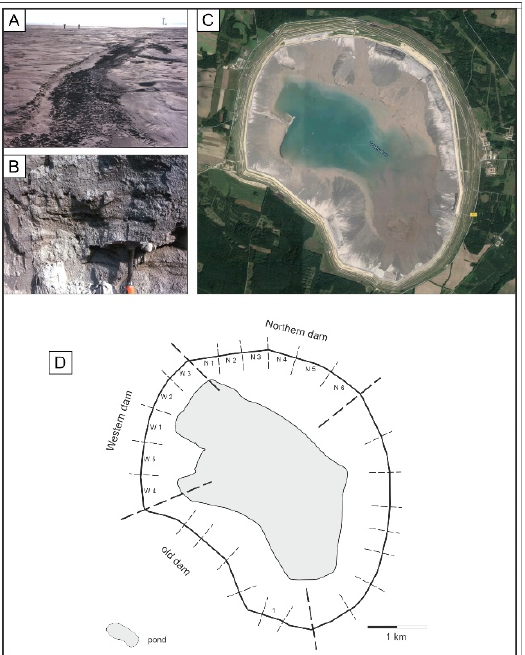
Figure 2. ( A ) Photograph of the ZM northern dam, view from the crown; ( B ) enlargement of A; sedimentary record in a profile, hammer as a scale; ( C ) ZM tailing location on Google Maps (accessed 27 May 2021); ( D ) sampling scheme from northern and western dam, the old dam on the picture before reconstruction (before 2021).